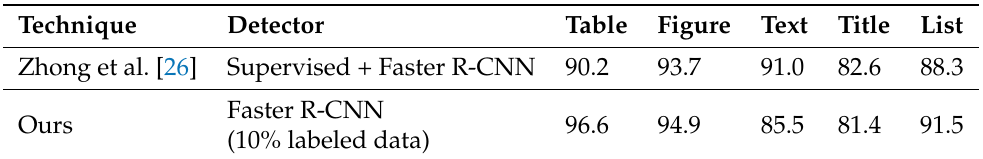
Figure 8. The results of our model with Faster R-CNN and ResNet101 that is trained on 10% of PubLayNet labeled data. Blue represents True Positives and Red represents False Positives. In this figure, ( left ) represents a couple of samples with True Positives, ( right ) depicts True Positives and False Positives. Table 7. Class-wise performance AP (0.5:0.95) comparison of Faster R-CNN baseline model trained on fully labeled data with our semi-supervised model which is trained on 10% labeled PubLayNet dataset. The model uses Faster R-CNN and ResNet101.